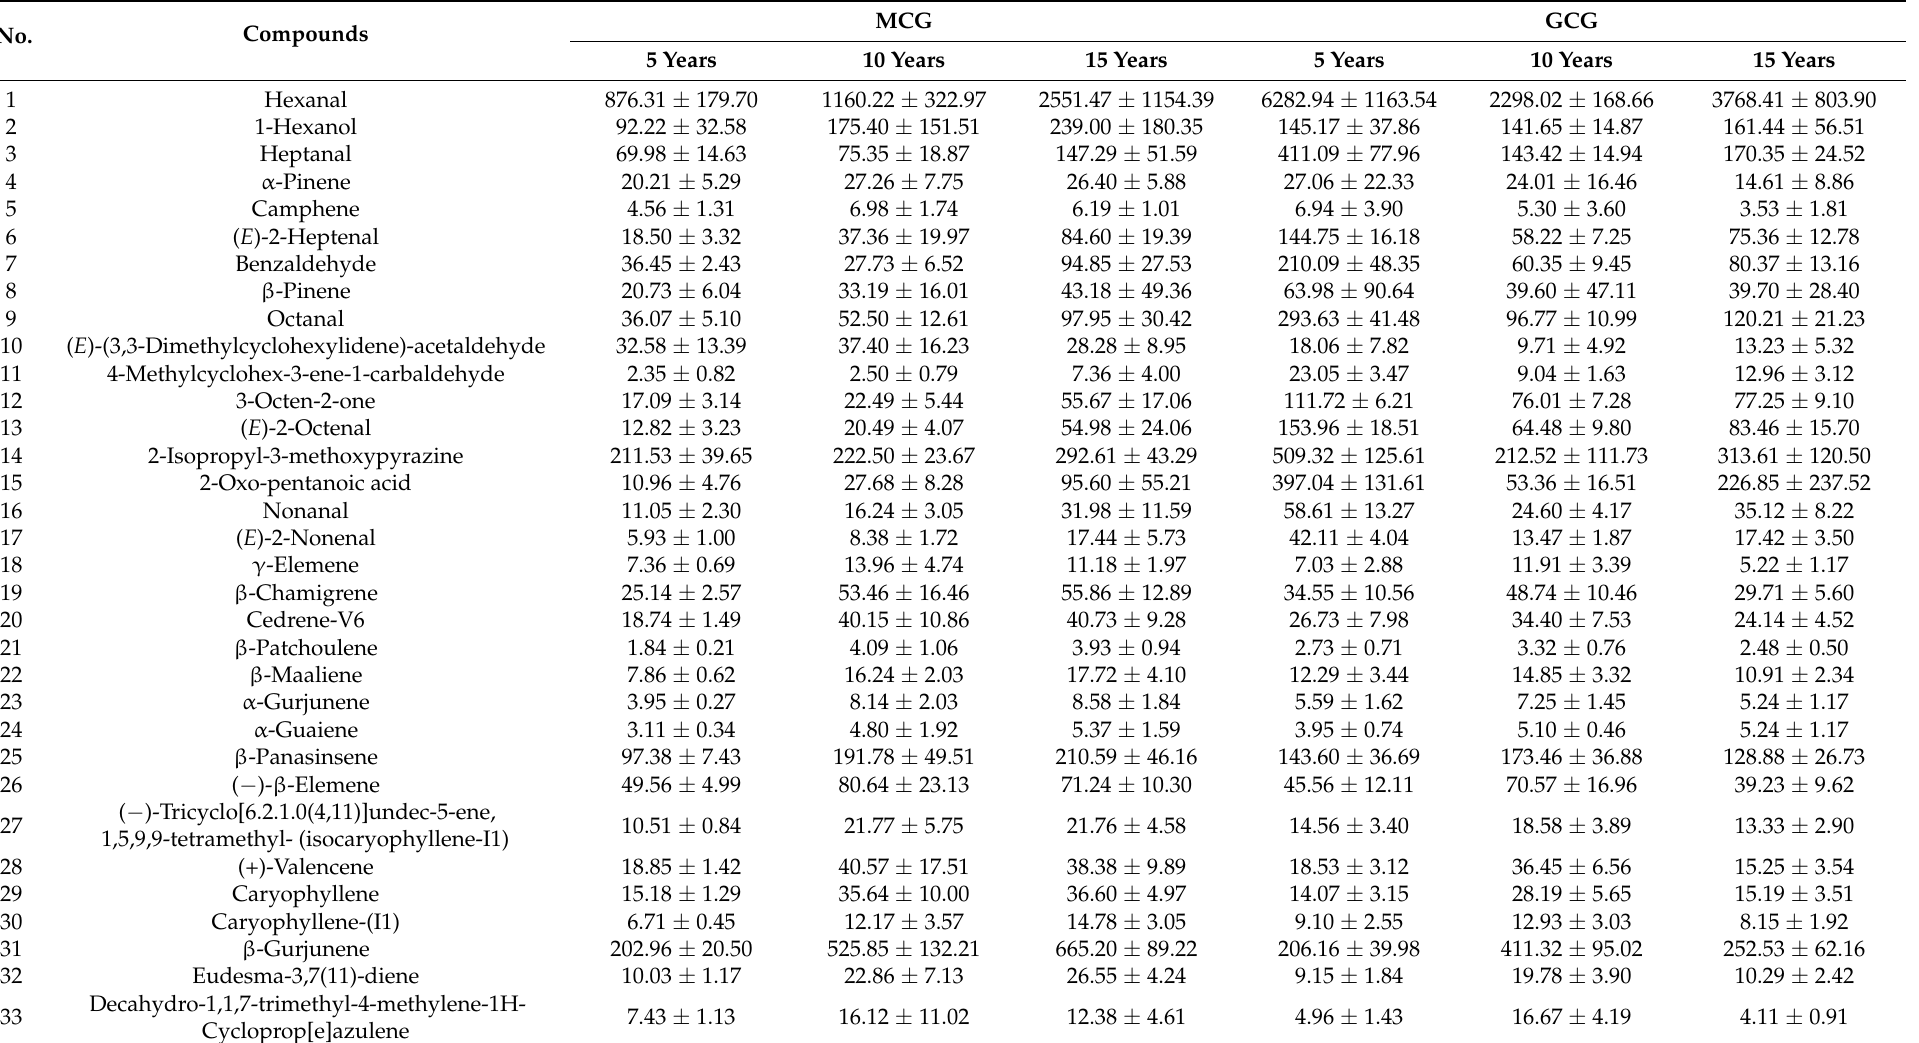
Table 1. The contents of the volatile compounds in MCG 5-,10-,15-years and GCG 5-,10-,15-years (ng/g, n =